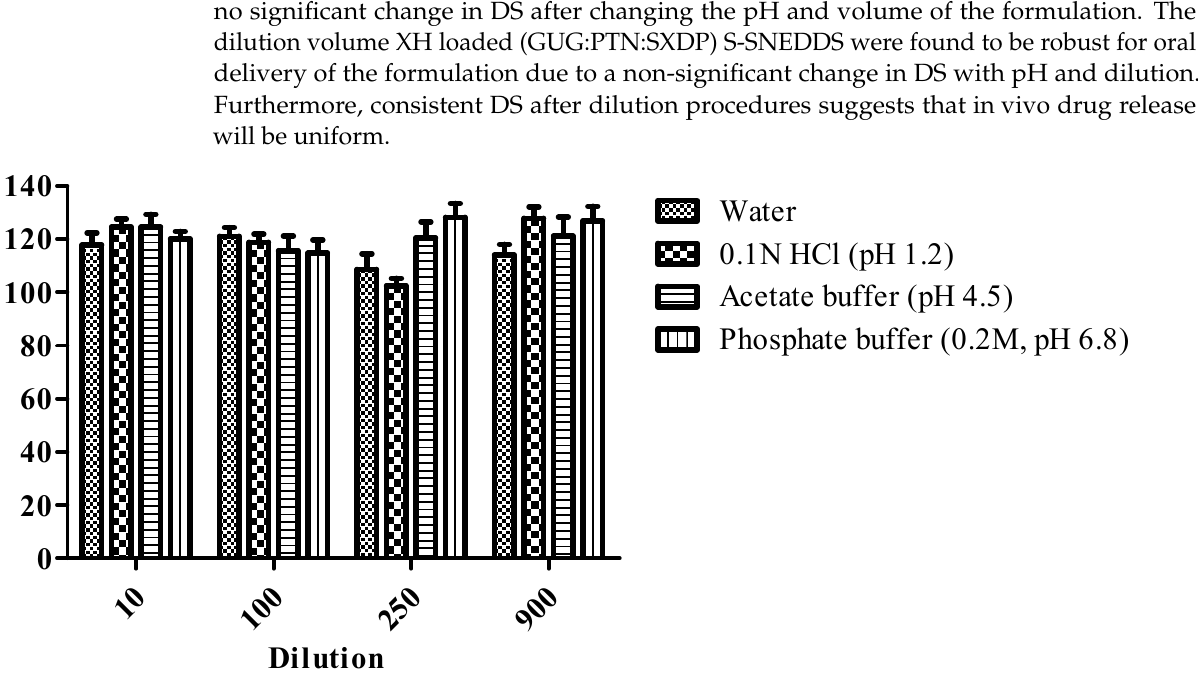
Figure 5. Effect of change in dilution volume and pH on mean droplet size (Mean ± s.d.; n = 3) .